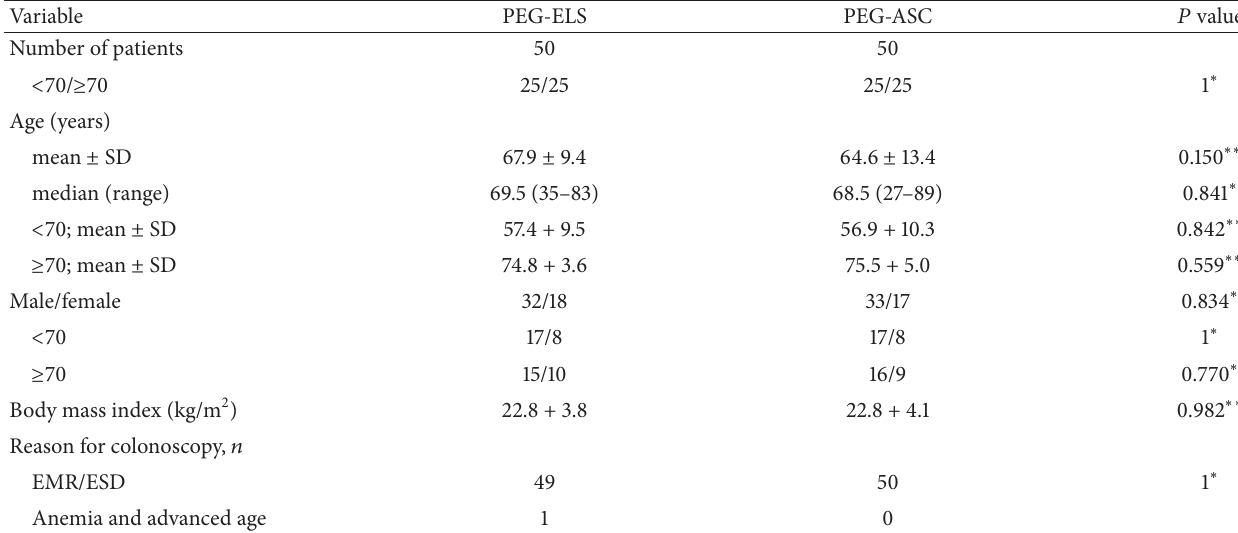
Table 1: Patient